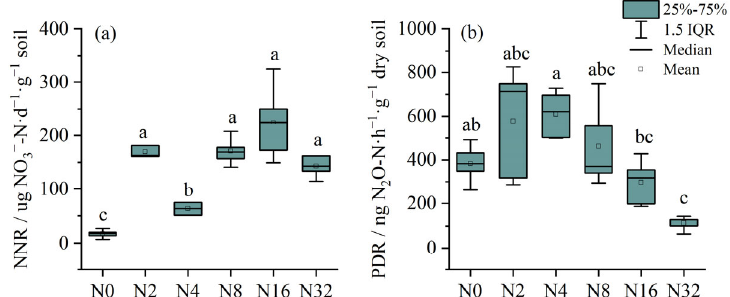
Figure 6. Boxplot of the soil nitrification and denitrification rates under different N application rates. ( a ) Net nitrification rate (NNR), and ( b ) potential denitrification rate (PDR). In all, 25 − 75% represents the interquartile range (IQR). The different lowercase letters indicate significant differences among all the different N application treatments ( p < 0.05). N0 is the control (0 g N · m − 2 · yr − 1 application), N2 is the 2 g N · m − 2 · yr − 1 application, N4 is the 4 g N · m − 2 · yr − 1 application, N8 is the 8 g N · m − 2 · yr − 1 application, N16 is the 16 g N · m − 2 · yr − 1 application, and N32 is the 32 g N · m − 2 · yr − 1 application.